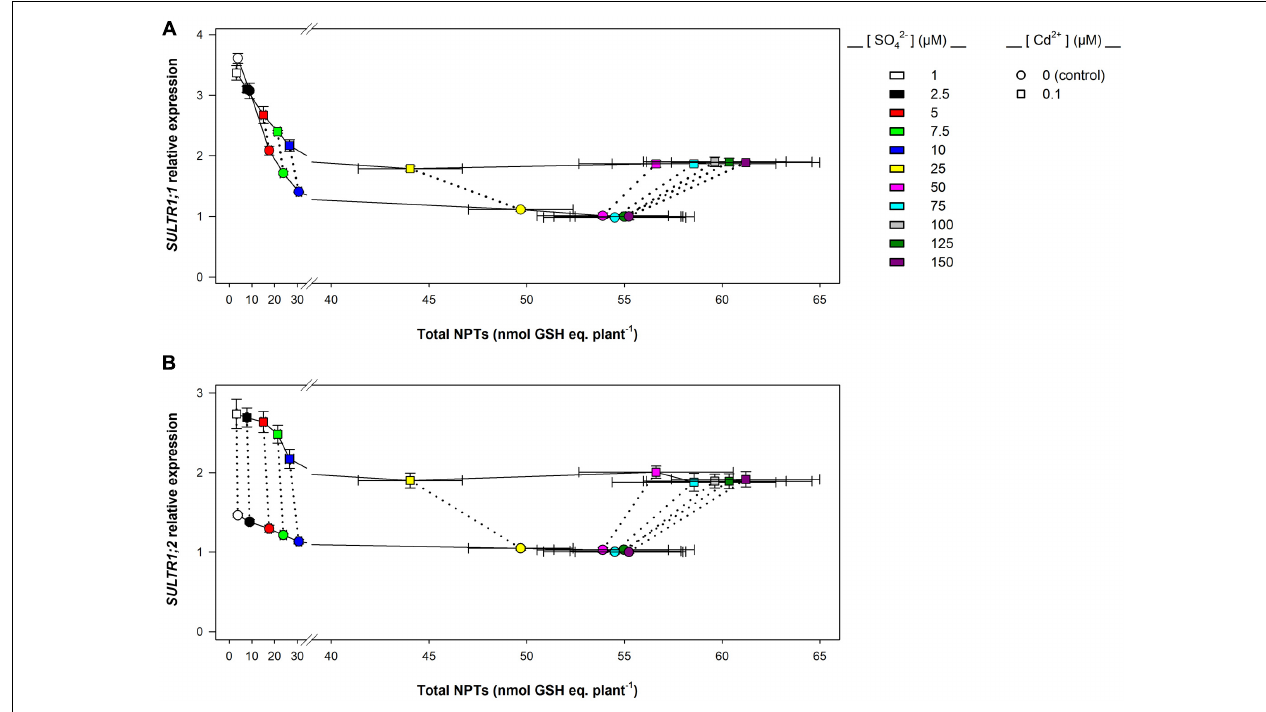
Figure S4. Solid lines link data about plants grown under different sulfate concentrations in the absence (circles) or presence of 0.1 µ M Cd 2 + (squares). Dotted lines link data about plants grown under the same sulfate concentration. Data reported in each plot are means and SE of two experiments run in triplicate ( n =